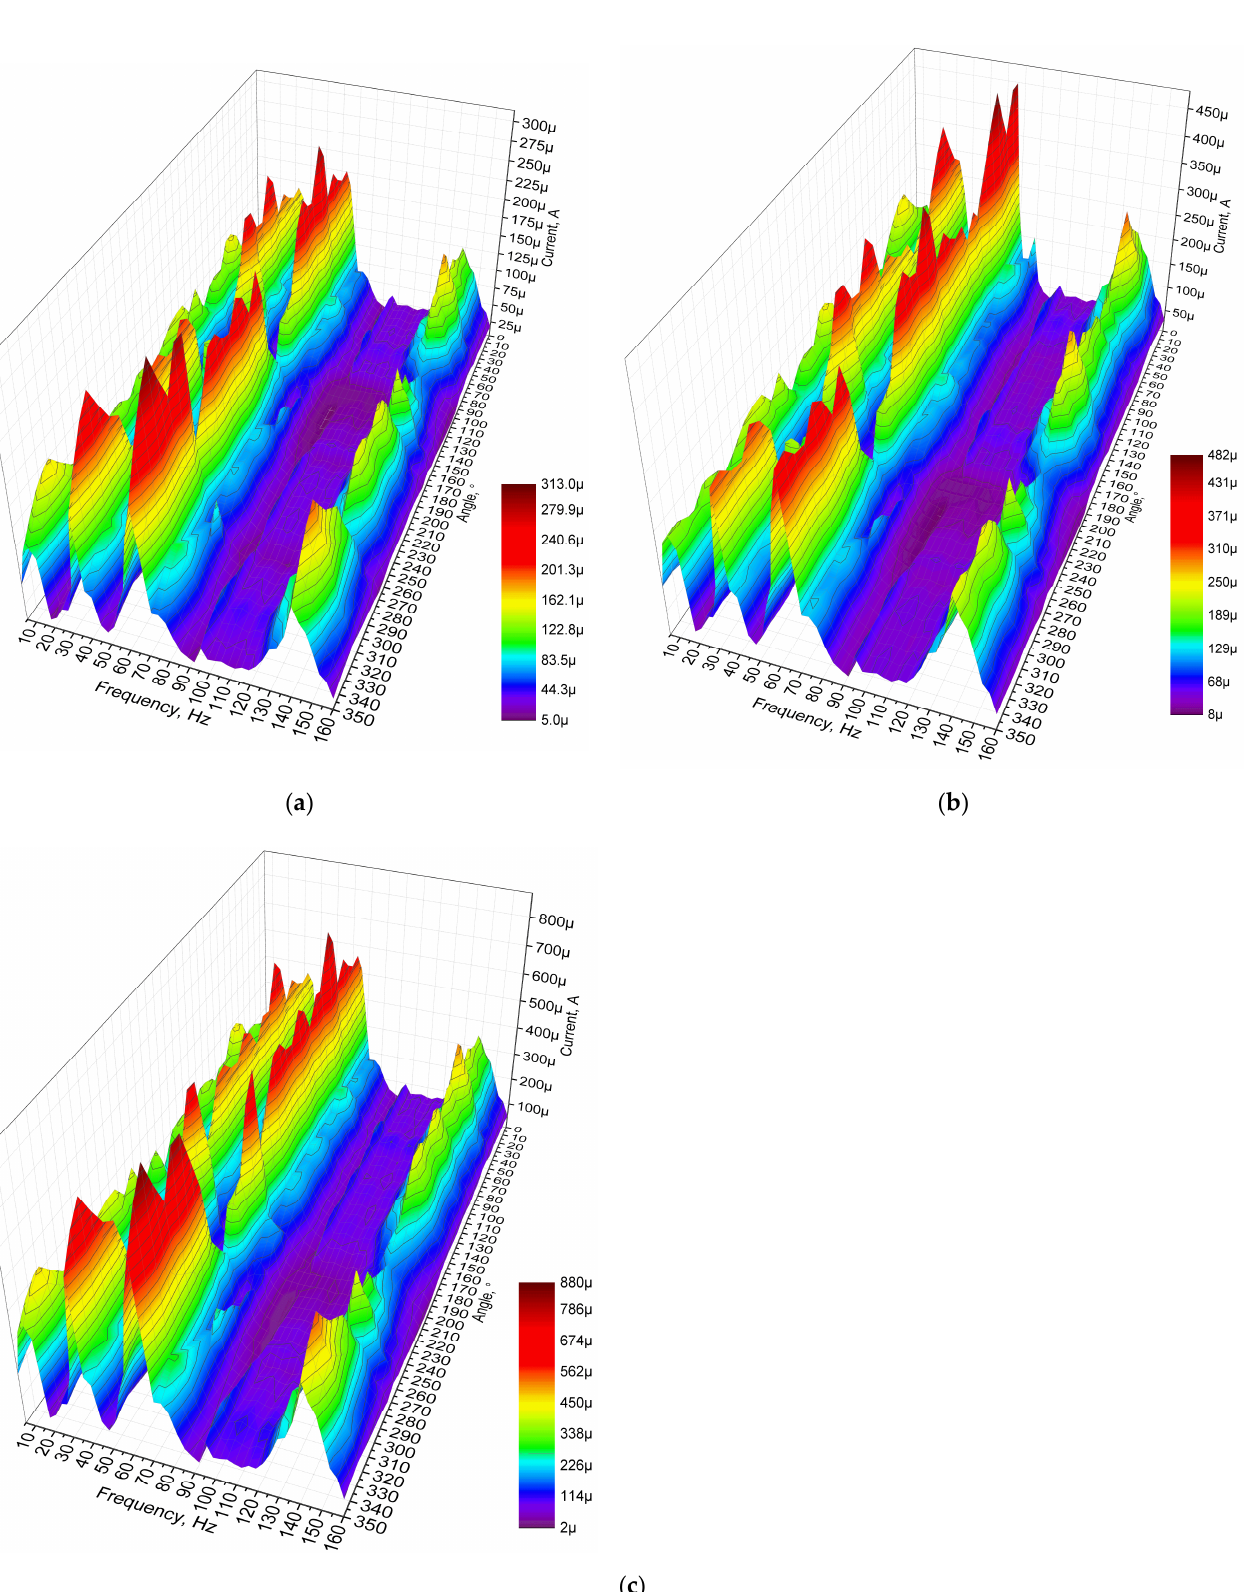
Figure 20. Frequency—current—angle of excitation motion characteristics of the energy harvester with different loads; ( a )—load equal to 1 MΩ; ( b )—load equal to 500 kΩ; ( c )— load equal to 250 kΩ.